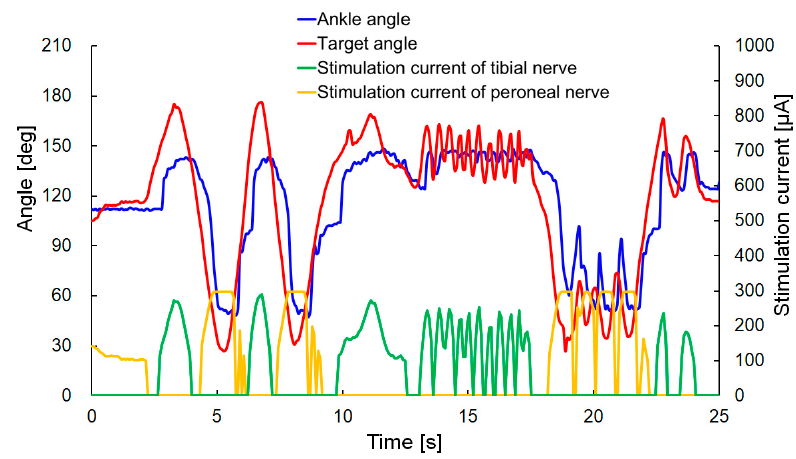
Figure 13. Experimental results of visual feedback control of rat ankle joint when K p = 1 and K i = 0.02.